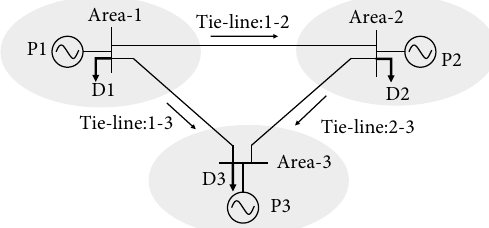
Table 2 The optimal schedule of generators and tie-lines